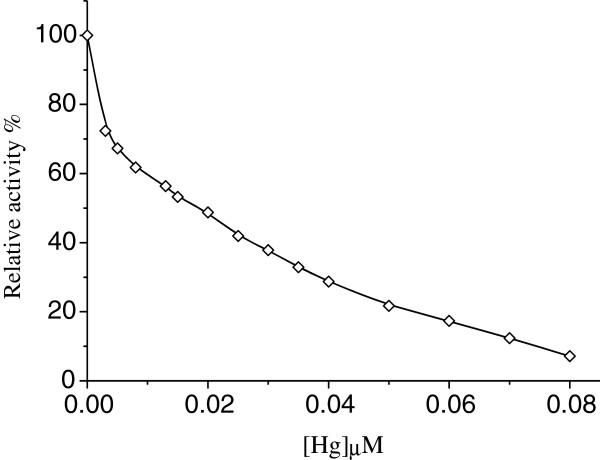
Effect of Hg2+on jack bean urease activity. Conditions were 1 mL assay system containing 0.02 M KH2PO4- K2HPO4 buffer (pH 7.4), 0.67 mM of urea, 6 μg ml-1 of enzyme and different concentrations of Hg2+ at 25°C for 15 min.